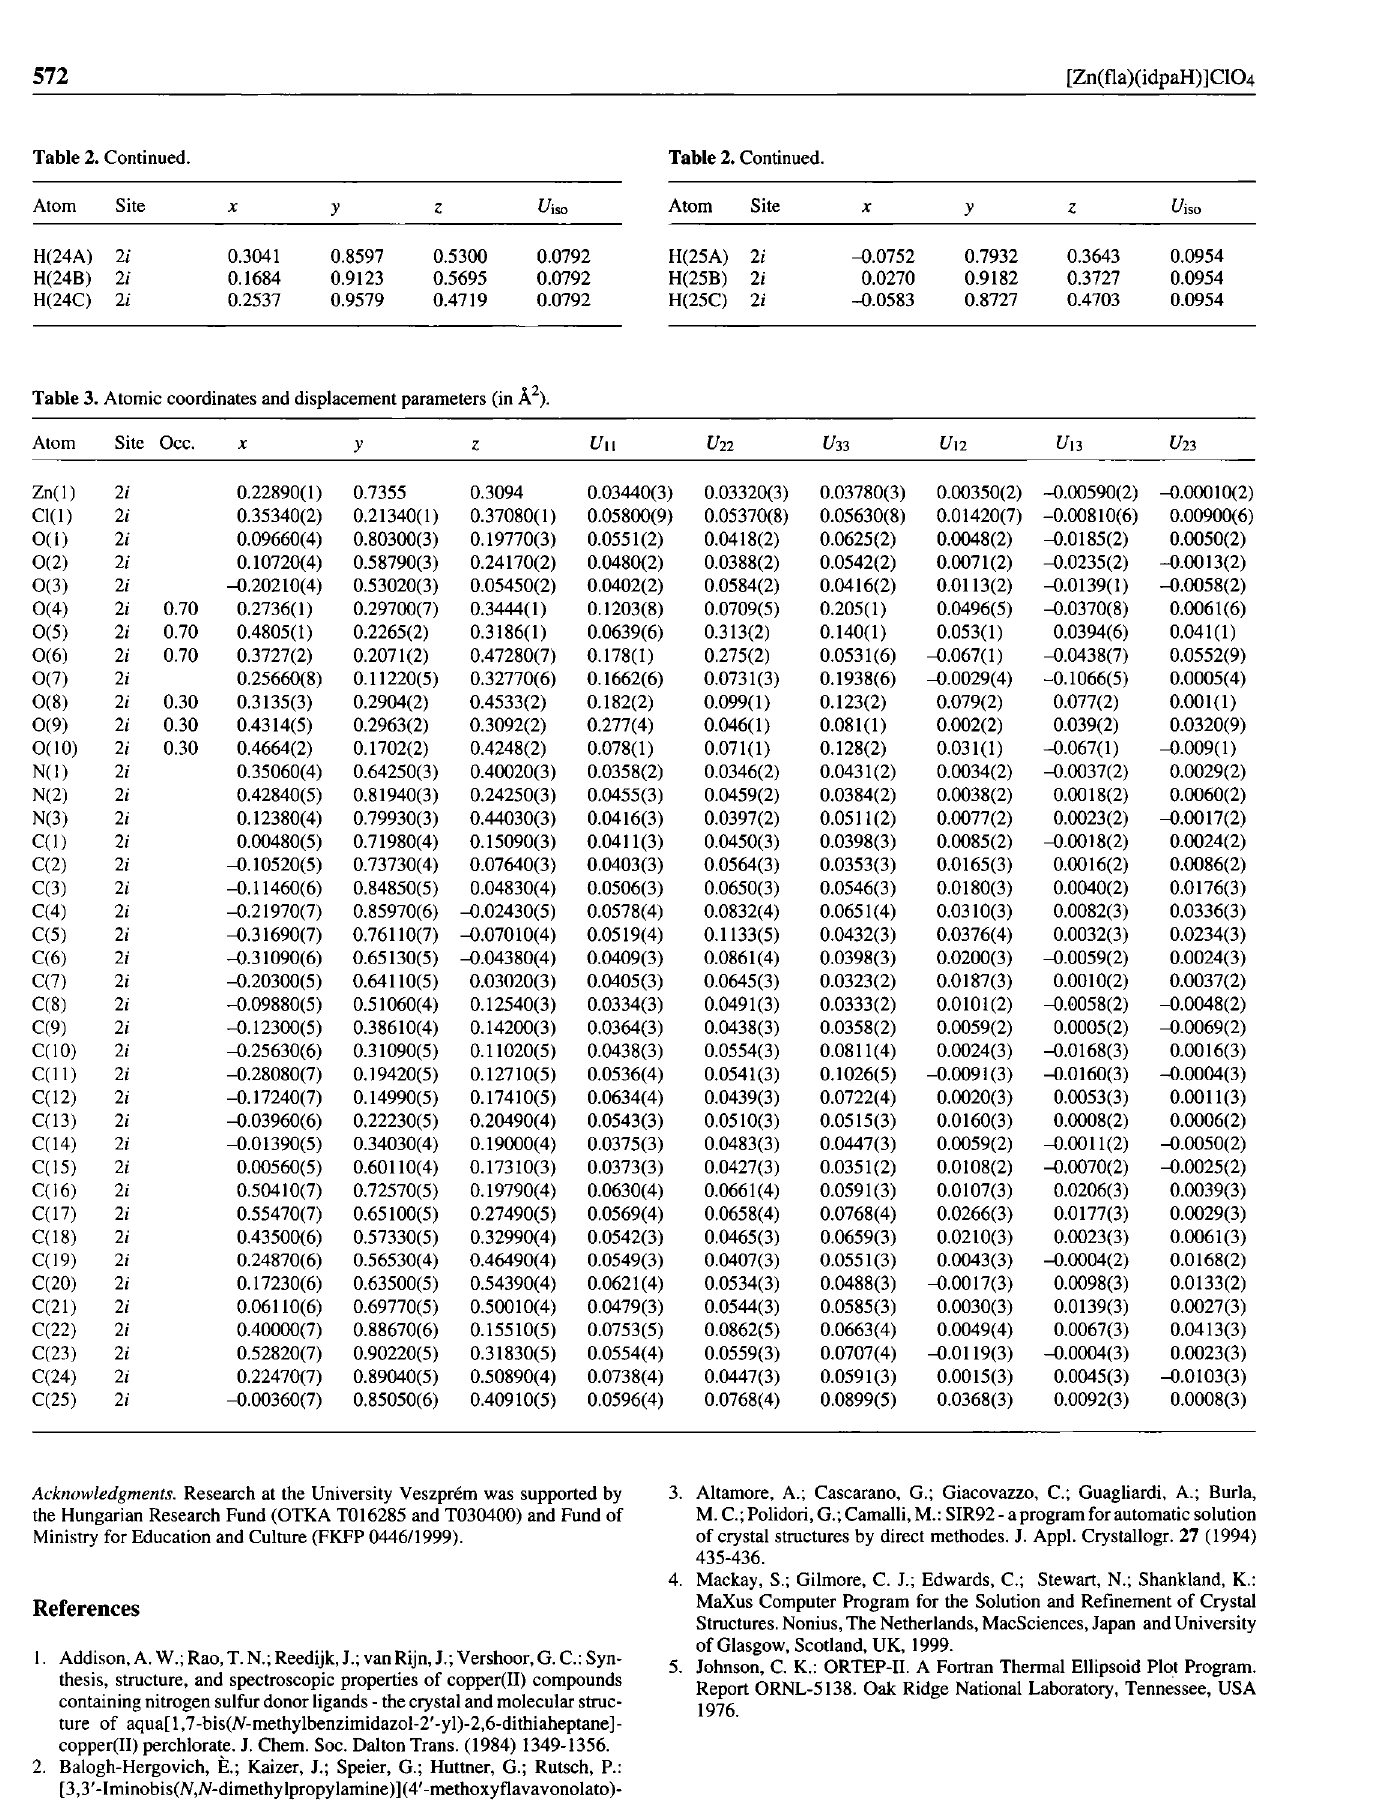
Table 3. Atomic coordinates and displacement parameters (in À 2